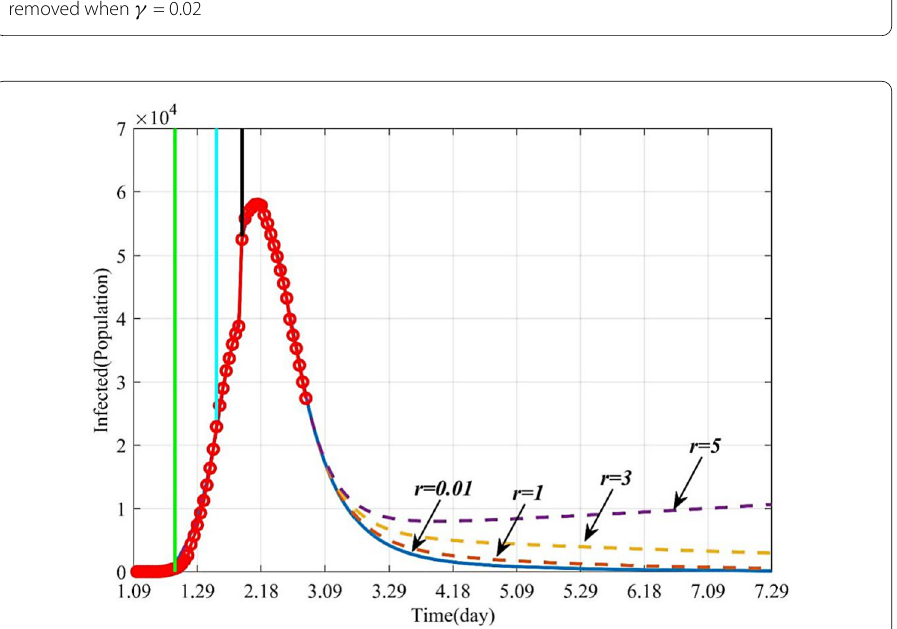
Figure 10 Dynamic trends of the infected with different r . The solid line represents the trends of the infected with the current r . The orange dotted line represents the trends of the infected when r = 1. The yellow dotted line represents the trends of the infected when r = 3. The purple dotted line represents the trends of the infected when r =